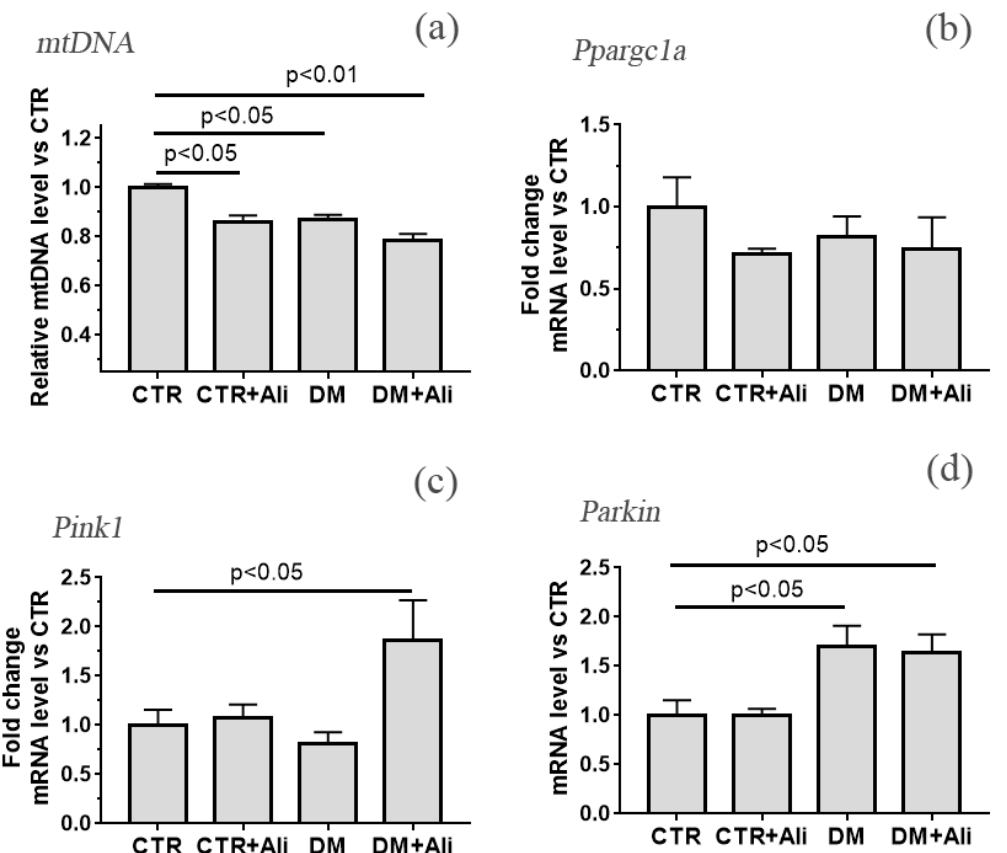
Figure 6. The relative mtDNA levels ( a ) and the mRNA levels of Ppargc1a ( b ), Pink1 ( c ), Parkin ( d ) in the heart of experimental animals. The values are given as means ± SEM ( n = 6).